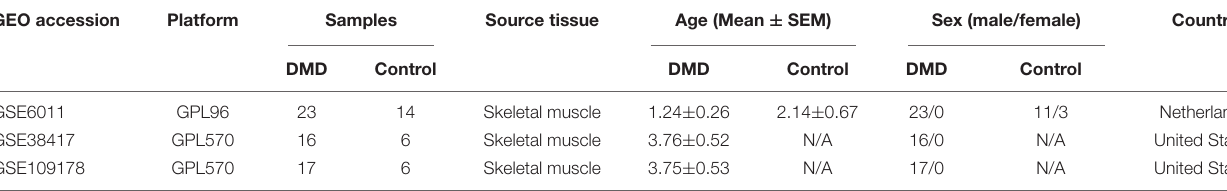
TABLE 1 | Information for GSE6011, GSE38417, and GSE109178. GEO